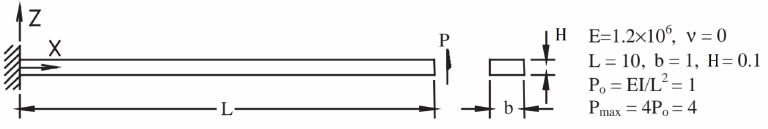
Figure 2. Cantilever subjected to end shear